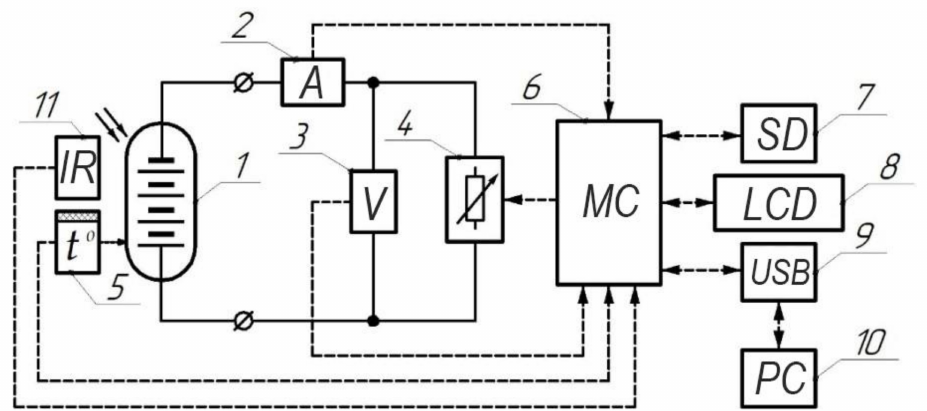
Figure 1. Block diagram of the information-measuring complex (1—PV module; 2—current sensor; 3—voltage sensor; 4—special adjustable load; 5—solar cell and environment temperature sensor; 6—microcontroller; 7—electronic storage; 9—interface microcontroller; 10—personal computer; 11 — light